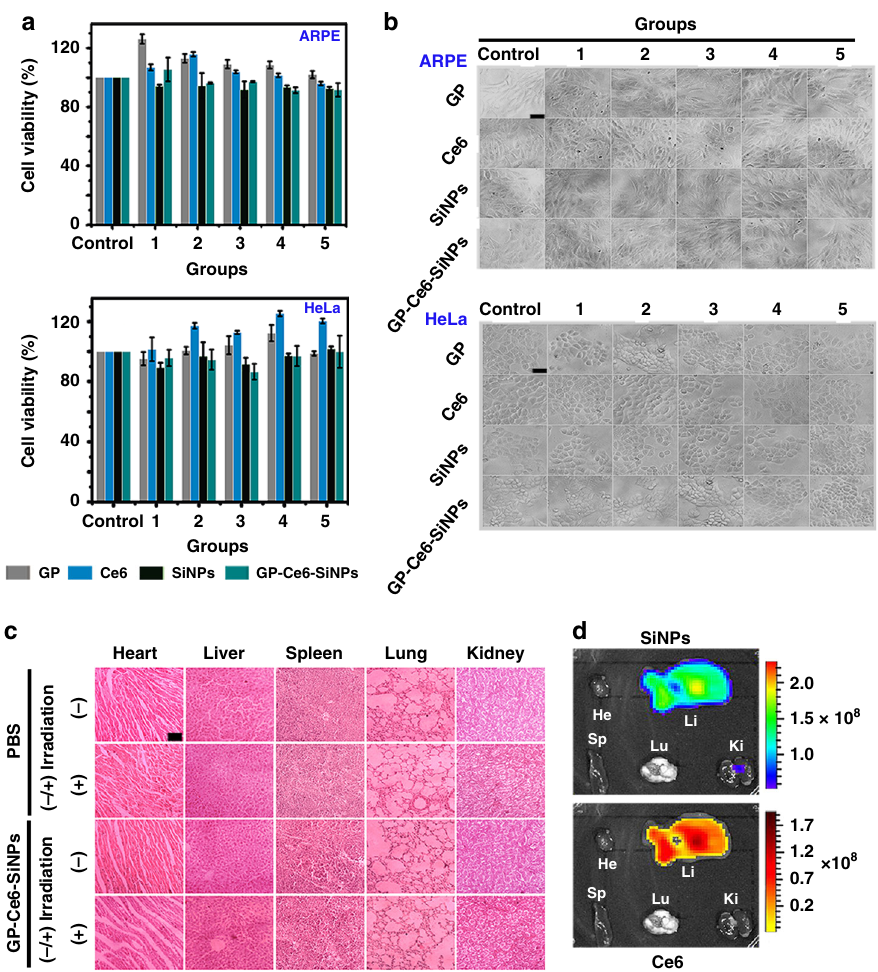
Fig. 7 In vitro and in vivo toxicity tests. Cell viability ( a ) and morphology ( b ) of ARPE (up, normal cells) and HeLa cells (down, cancer cells) treated with different dosages of GP, Ce6, SiNPs, and GP-Ce6-SiNPs for 24 h, respectively. The groups of “ Control, 1, 2, 3, 4, 5 ” represent series of concentrations of GP (0, 5, 2.5, 1.25, 0.625, 0.313 mg mL − 1 ), Ce6 (0, 100, 50, 25, 12.5, 6.25 μ g mL − 1 ), SiNPs and GP-Ce6-SiNPs (0, 10, 5, 2.5, 1.25, 0.625 mg mL − 1 ). All error bars represent the standard deviation determined from three independent assays. Scale bar: 50 μ m. c Histological evaluation of different organs (heart, liver, spleen, lung, and kidney) from healthy mice, which are suffered from 10-day treatment of PBS, PBS + irradiation, GP-Ce6-SiNPs, GP-Ce6-SiNPs + irradiation, respectively. Scale bar: 100 μ m. d Ex vivo dual-emission imaging of organs resected from healthy mice after 24 h post injection of GP-Ce6- SiNPs. First row (from left to right): heart (He), liver (Li); second row (from left to right): spleen (Sp), lung (Lu), and kidney (Ki). Source data are provided as a Source Data fi